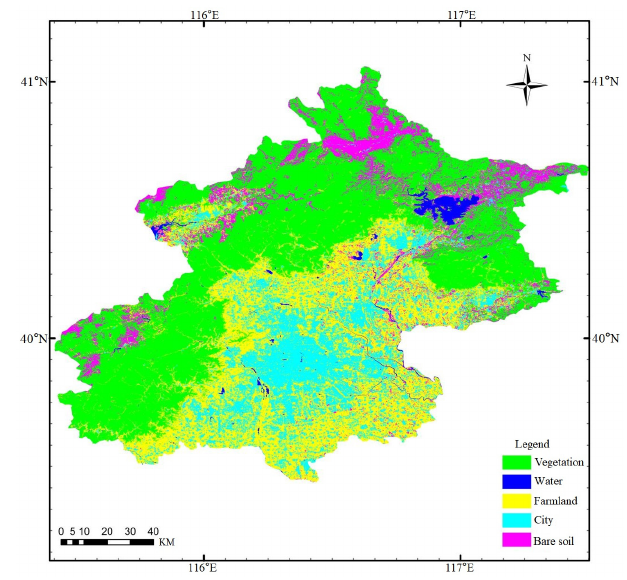
Figure 7. Classification results of GF-1 WFV images in Beijing.